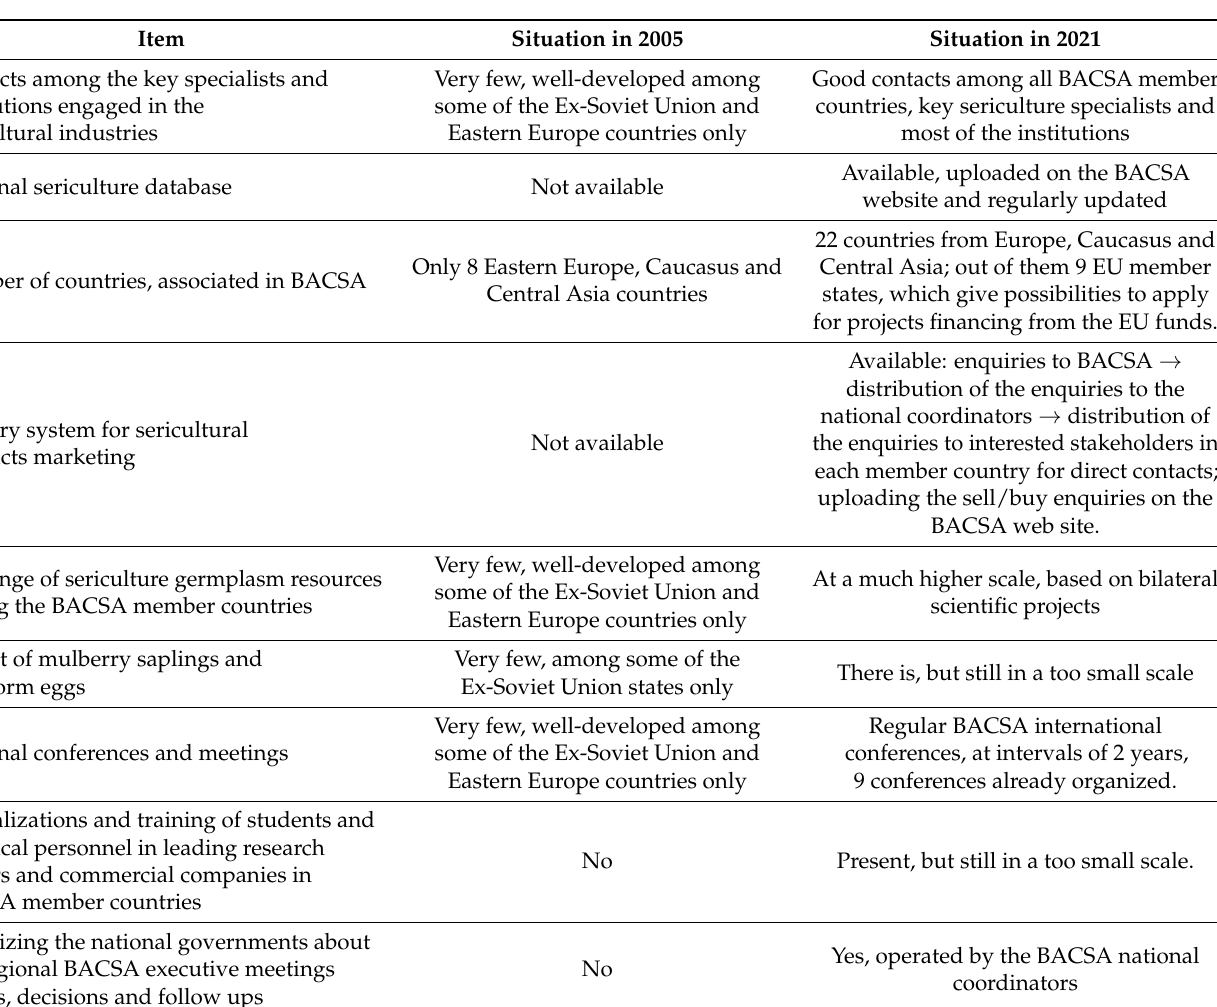
Table 3. BACSA’s activity results